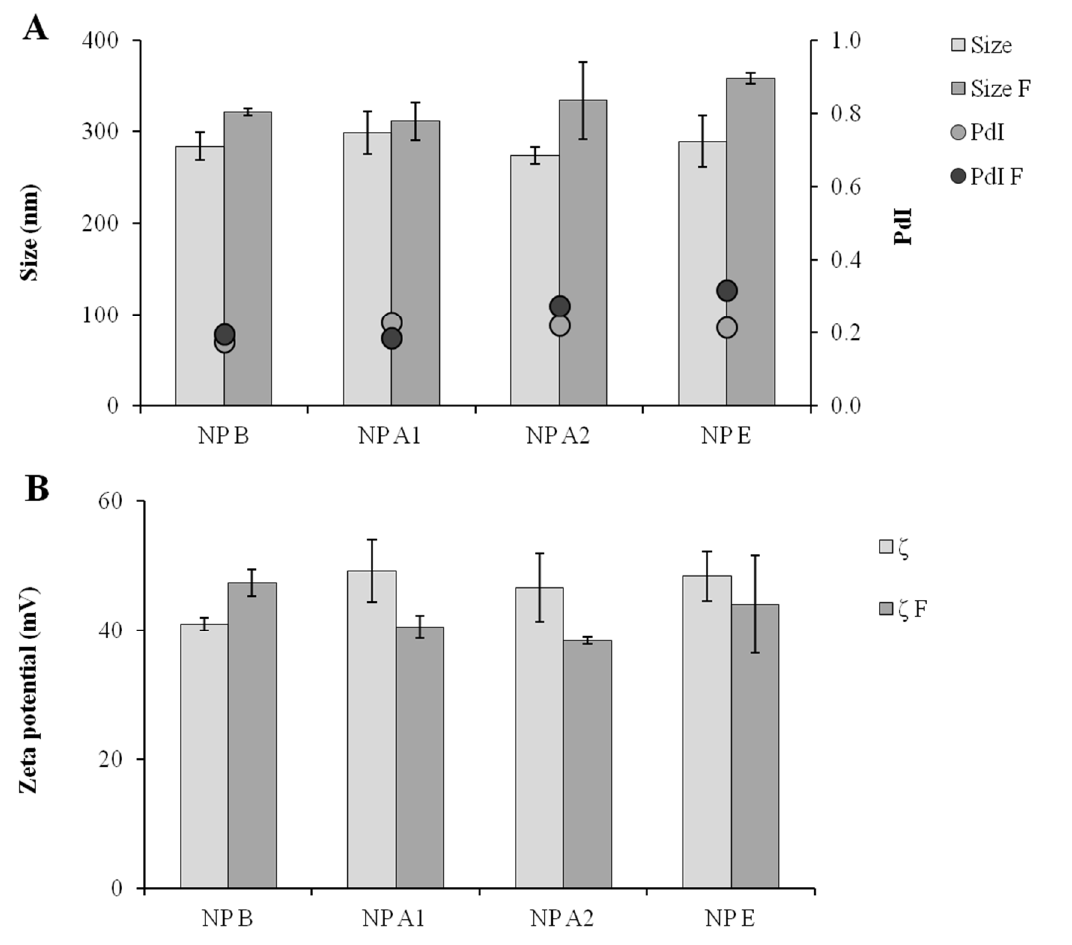
Figure 5. Comparison of the formulations in terms of particle size and polydispersity ( A ) and of zeta-potential ( B ) before and after freeze-drying and resuspension operation. Size: Size of the formulation before freeze-drying; Size F: Size after freeze-drying; PdI: Polydispersity of formulation before freeze-drying; PdI F: PdI after freeze-drying; ζ : Zeta-potential of formulation before freeze-drying; ζ F: Zeta-potential after freeze-drying; NP B: Chitosan/TPP/Poly (I:C) nanoparticles without peptides; NP A1: Chitosan/TPP/Poly (I:C) nanoparticles with 1338aa adsorbed at surface; NP A2: Chitosan/TPP/Poly (I:C) nanoparticles with 1338aa and PADRE adsorbed at surface; NP E: Chitosan/TPP/Poly (I:C) nanoparticles with 1338aa and PADRE encapsulated. Results are presented as mean ± standard deviation ( n =